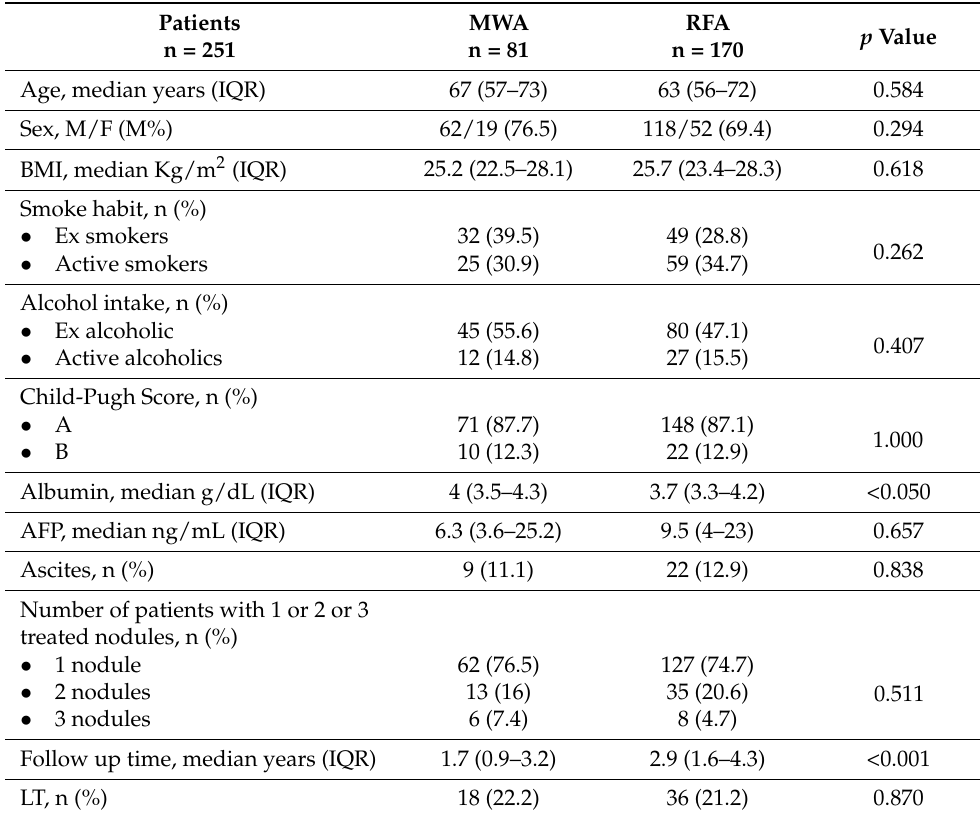
Table 1. Features of patients treated with MWA and RFA